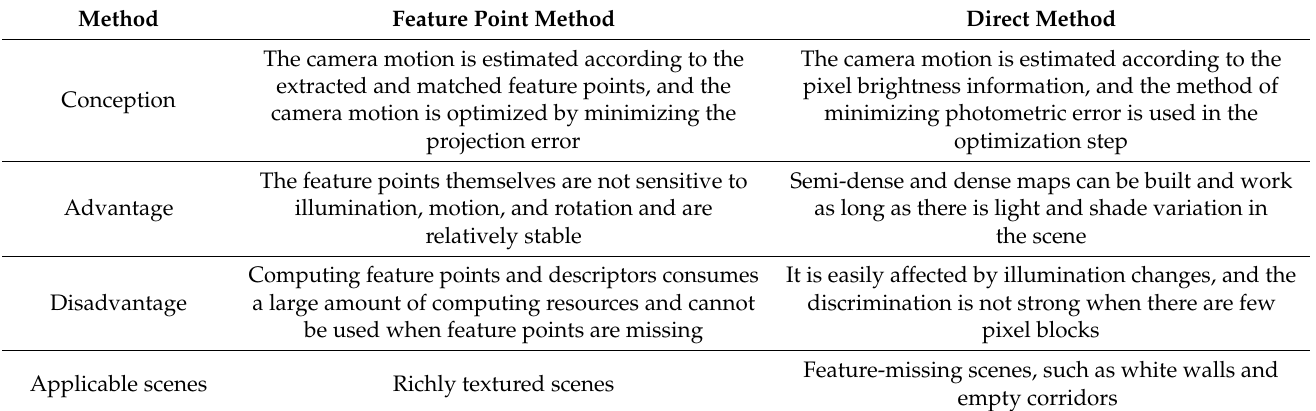
Table 6. Commonly used feature extraction algorithms in